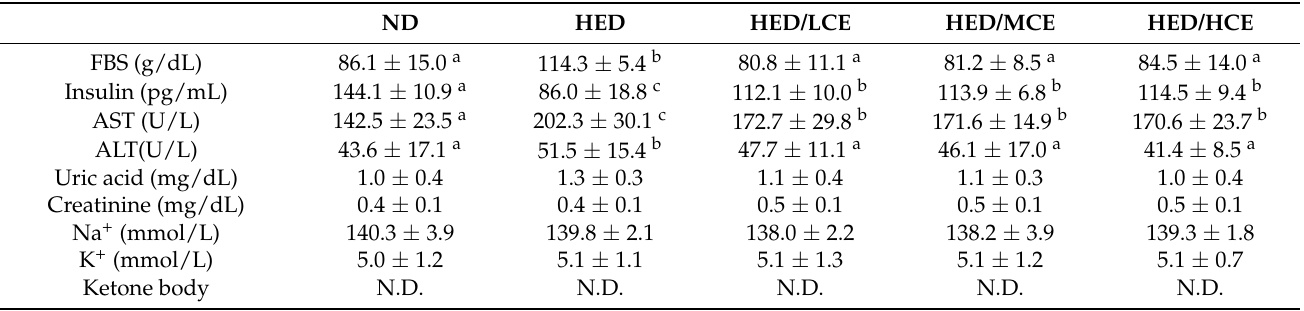
Table 2. Effects of phlorotannin-rich extracts from A. nodosum and F. vesiculosus on serum biochemical parameters of rats with high-energy diet–induced